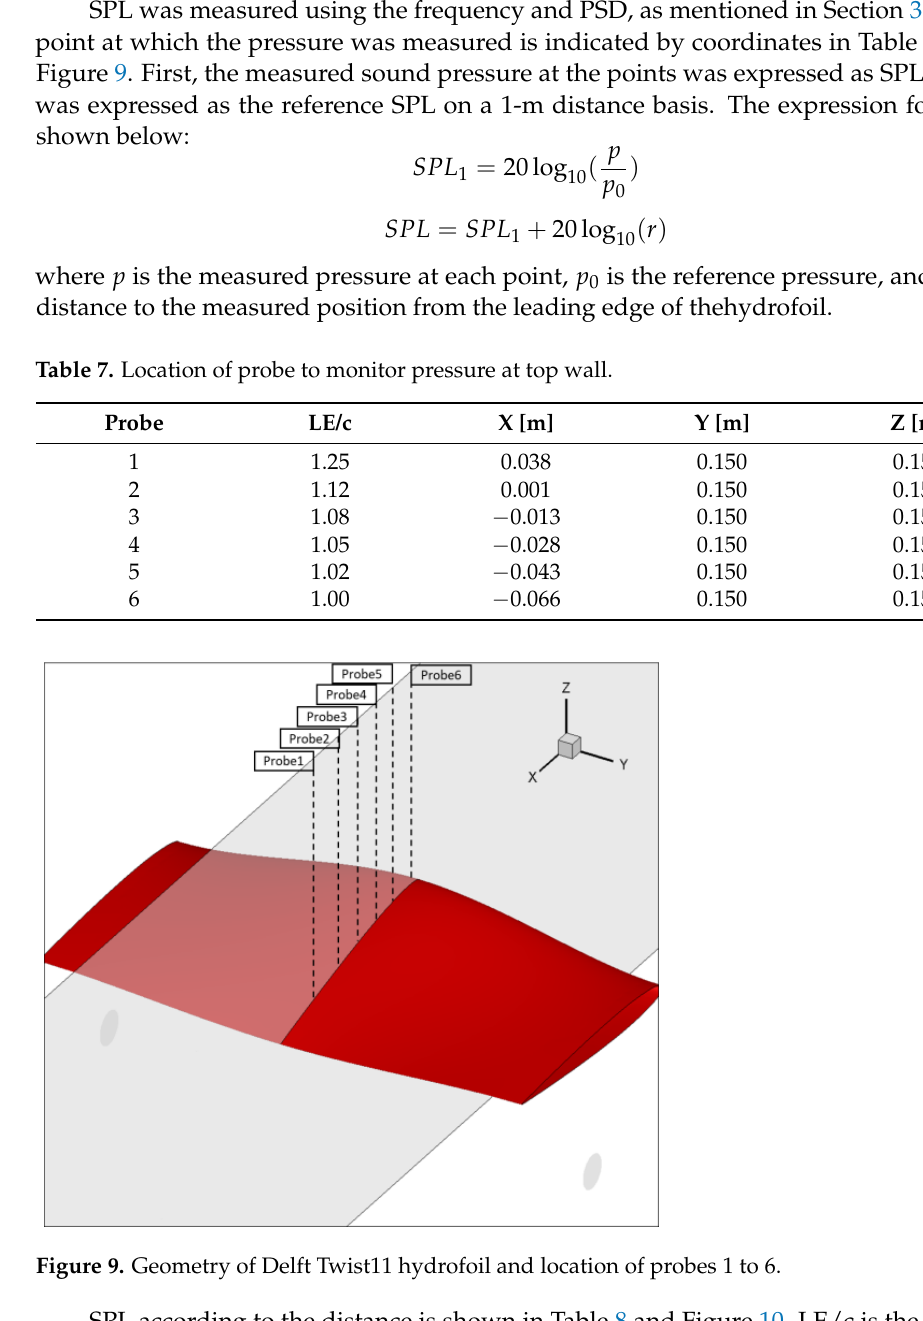
Figure 10. Sound pressure level (SPL) of wall pressure with LE/c according to turbulence model.